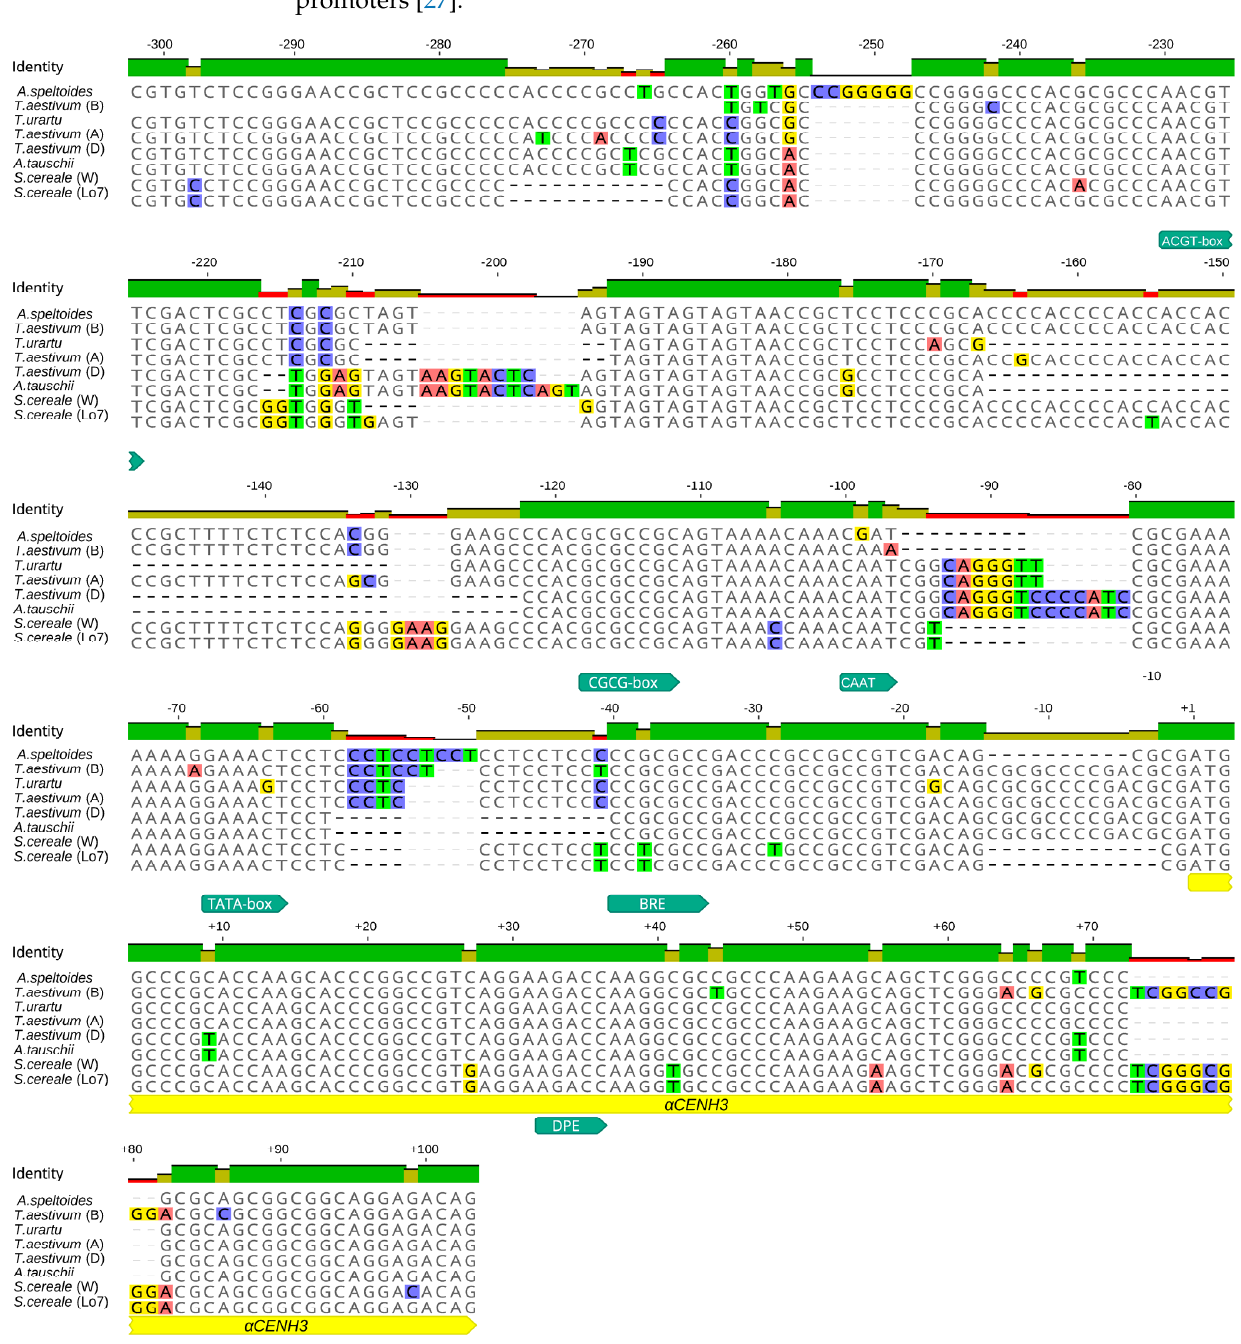
Figure 2. Alignment of nucleotide sequences in − 300 and +100 regions around the TSSs of α CENH3 , where functional motifs were searched for. Functional motifs appear as turquoise fingerpost arrows. The gene transcriptional regions appear as yellow fingerpost arrows.